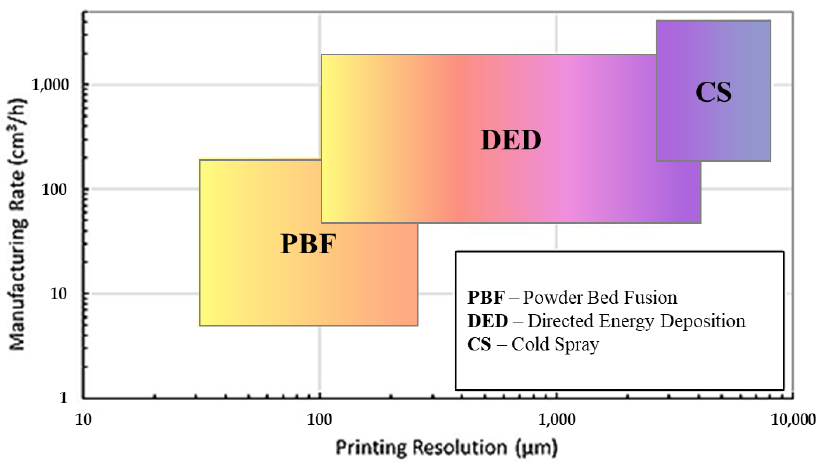
Figure 3. The relationship between the manufacturing rate and printing resolution for cold-spray- and laser-based AM processes. Adapted from Zou [54], Copyright 2021, with permission from the American Chemical Society.